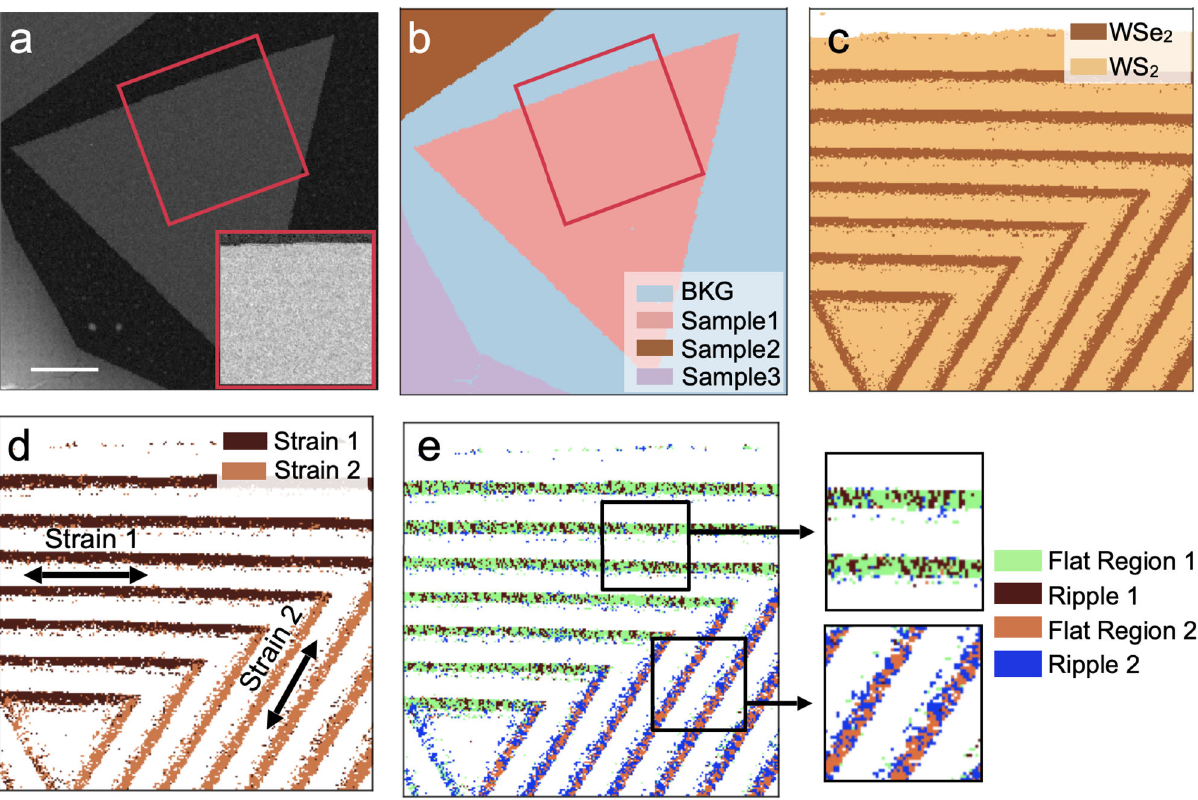
Fig. 3 Clustering results on WS 2 – WSe 2 superlattices. a ADF-STEM images of the 2D multi-junction superlattice with a zoomed-in area shown in the inset. The ADF contrast is dominated by heavy tungsten atoms, thus no superlattice structure appears. Scale bar, 500 nm. b Real-space map of the clustering results from the 4D dataset of the WS 2 – WSe 2 multi-junction sample, where different fl akes are identi fi ed from the substrate. c Zoomed-in real-space maps of the multi-junction sample area shown in the red box in ( a ). d Real-space map of the sub-clustering results in WSe 2 with two colors indicating different strain pro fi les. e Real-space map of another clustering round on each subcluster in ( d ), providing more structural details of lattice ripples in WSe 2 due to the